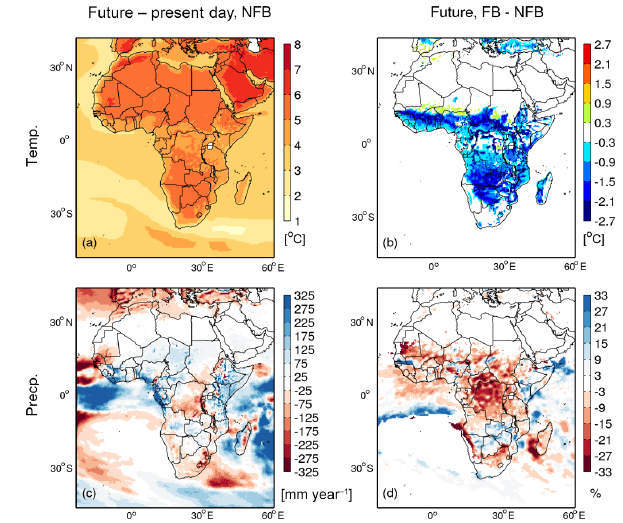
Figure 3. Changes in surface temperature and precipitation due to climate change and vegetation feedback. The calculation of climate change signal and vegetation feedbacks as well as present-day and future periods is defined in Sect. 2.2. For (d) , the percentage is cal- culated as the difference between FB and NFB (vegetation feed- back) divided by the present-day level and multiplied by 100. Grid points with annual mean precipitation <20mmyr − 1 are skipped.